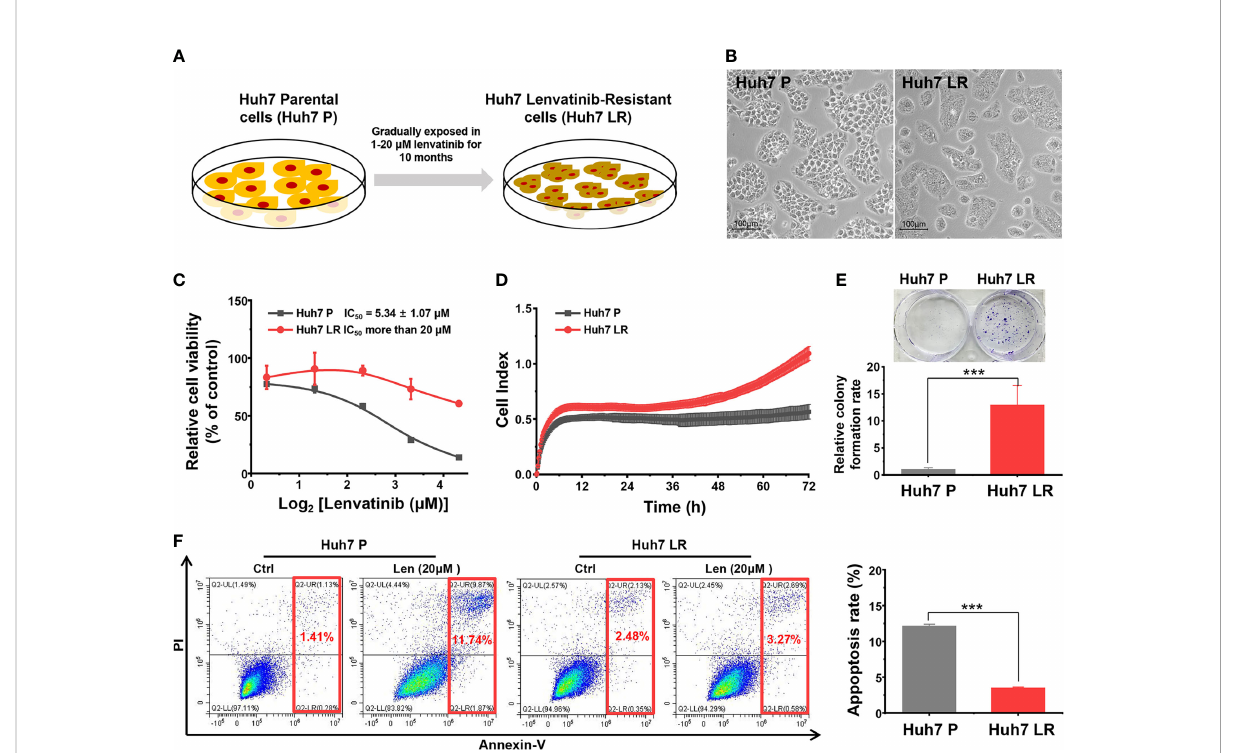
FIGURE 1 Successfully established Huh7 LR cell line. (A) The timeline and lenvatinib concentration. (B) The representative morphology of the Huh7 P and Huh7 LR cell lines. (C) The MTT assay during 96 h revealed that the Huh7 LR cell line had a substantially higher IC 50 than the Huh7 P cell line did. (D) RTCA revealed that Huh7 LR cells had a higher proliferation rate than Huh7 P cells did in medium containing 20 m M lenvatinib. (E) The Huh7 LR cell line exhibited higher colony forming ability than the Huh7 P cell line did in cultivation medium containing 20 m M